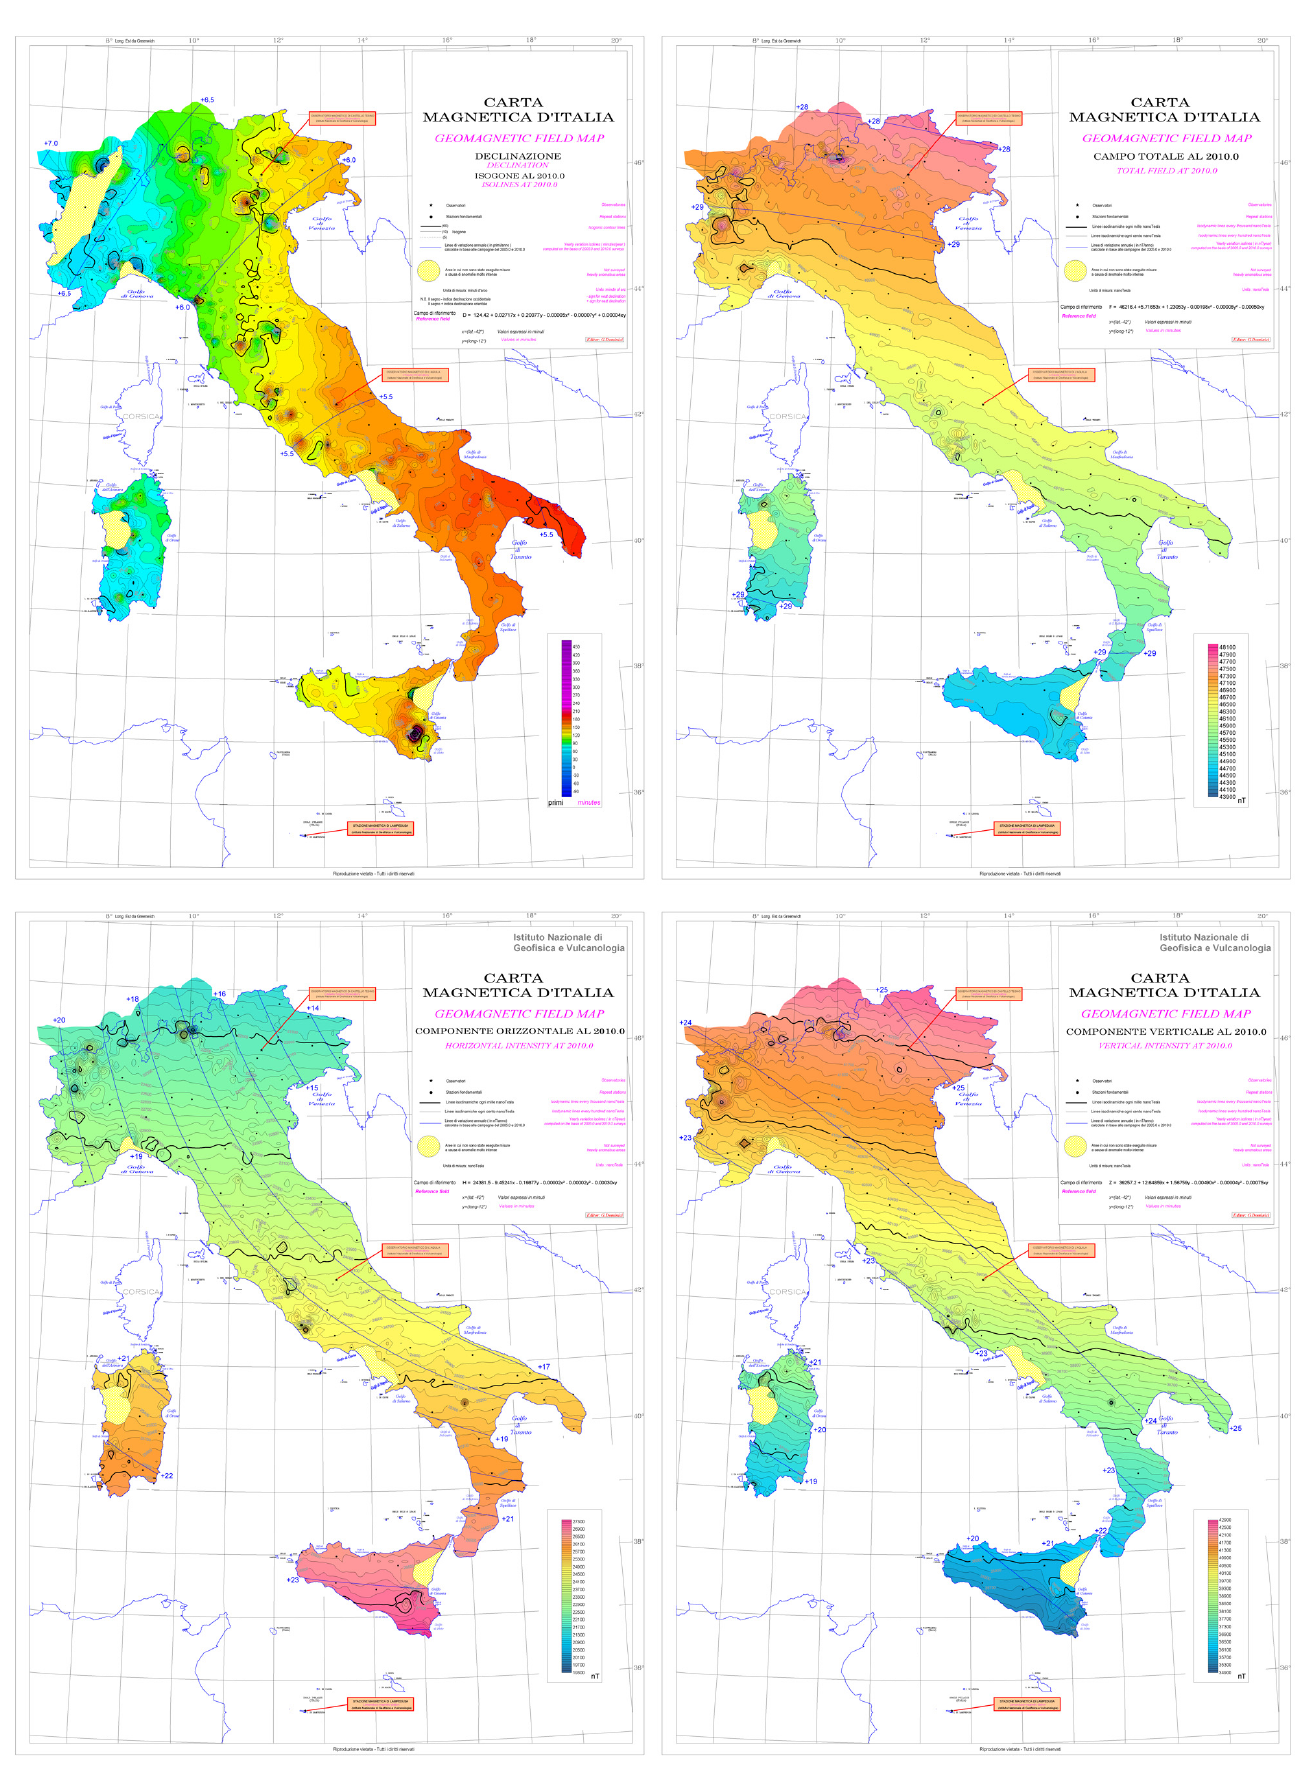
Figure 3. Top left: contour lines and coloured values of declination, D; top right: total intensity, F; bottom left: horizontal component, H; bottom right: vertical component, Z. All at 2010.0 over